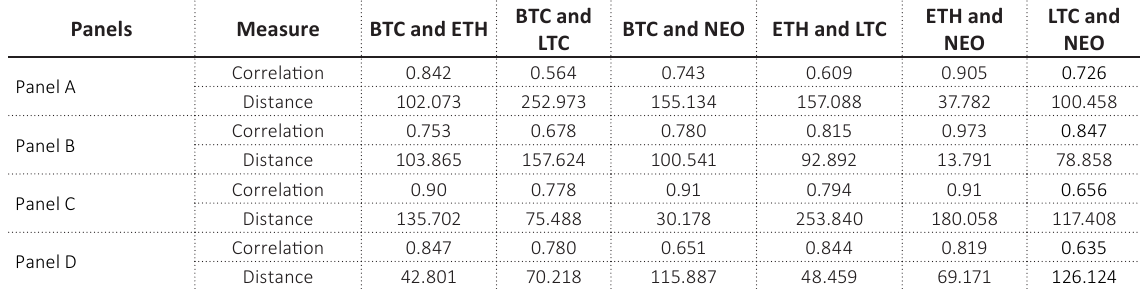
Table 2. Correlation and